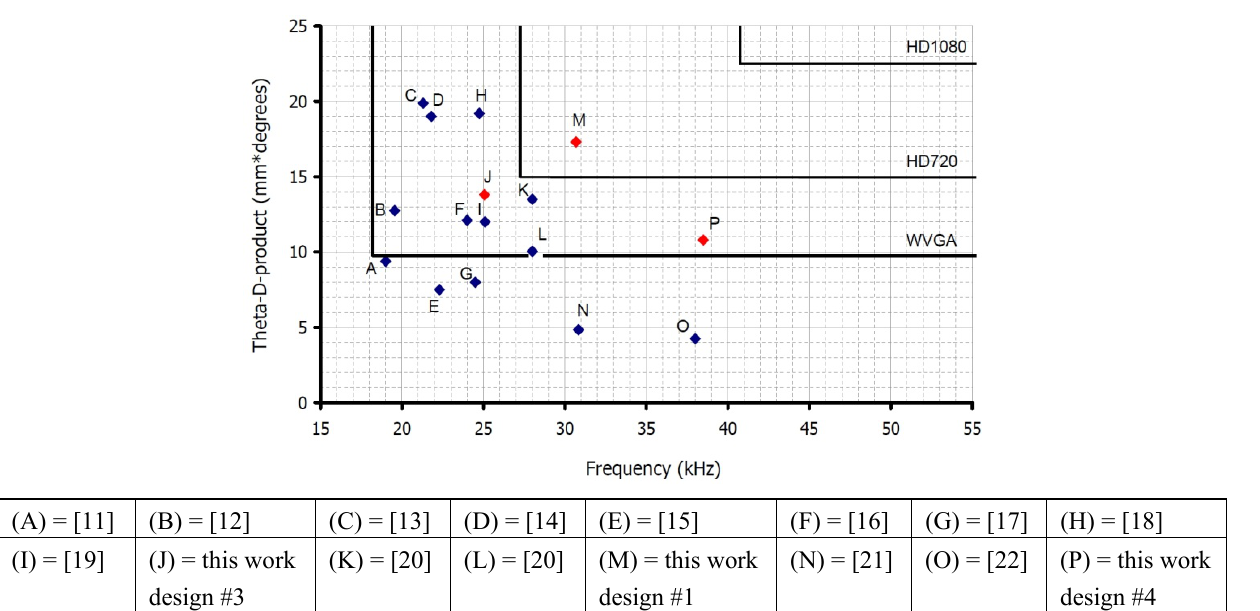
Figure 13. Comparison of fast axis MEMS scanning mirrors. The reference numbers of the corresponding published articles are listed in the caption